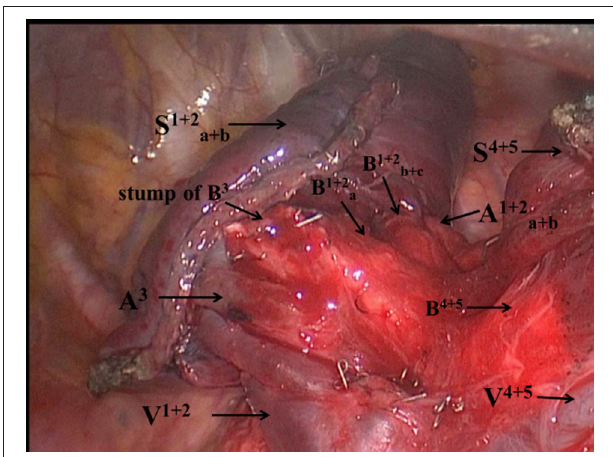
FIGURE 3 | The remaining left upper lobe was divided into two separate segments (S 1 + 2 a + b and S 4 + 5